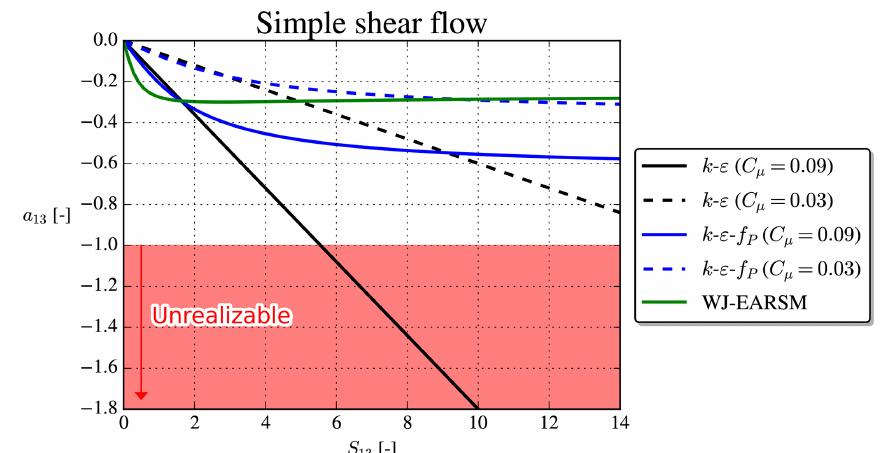
Figure 2. Analytical off-diagonal anisotropy in simple shear flow.